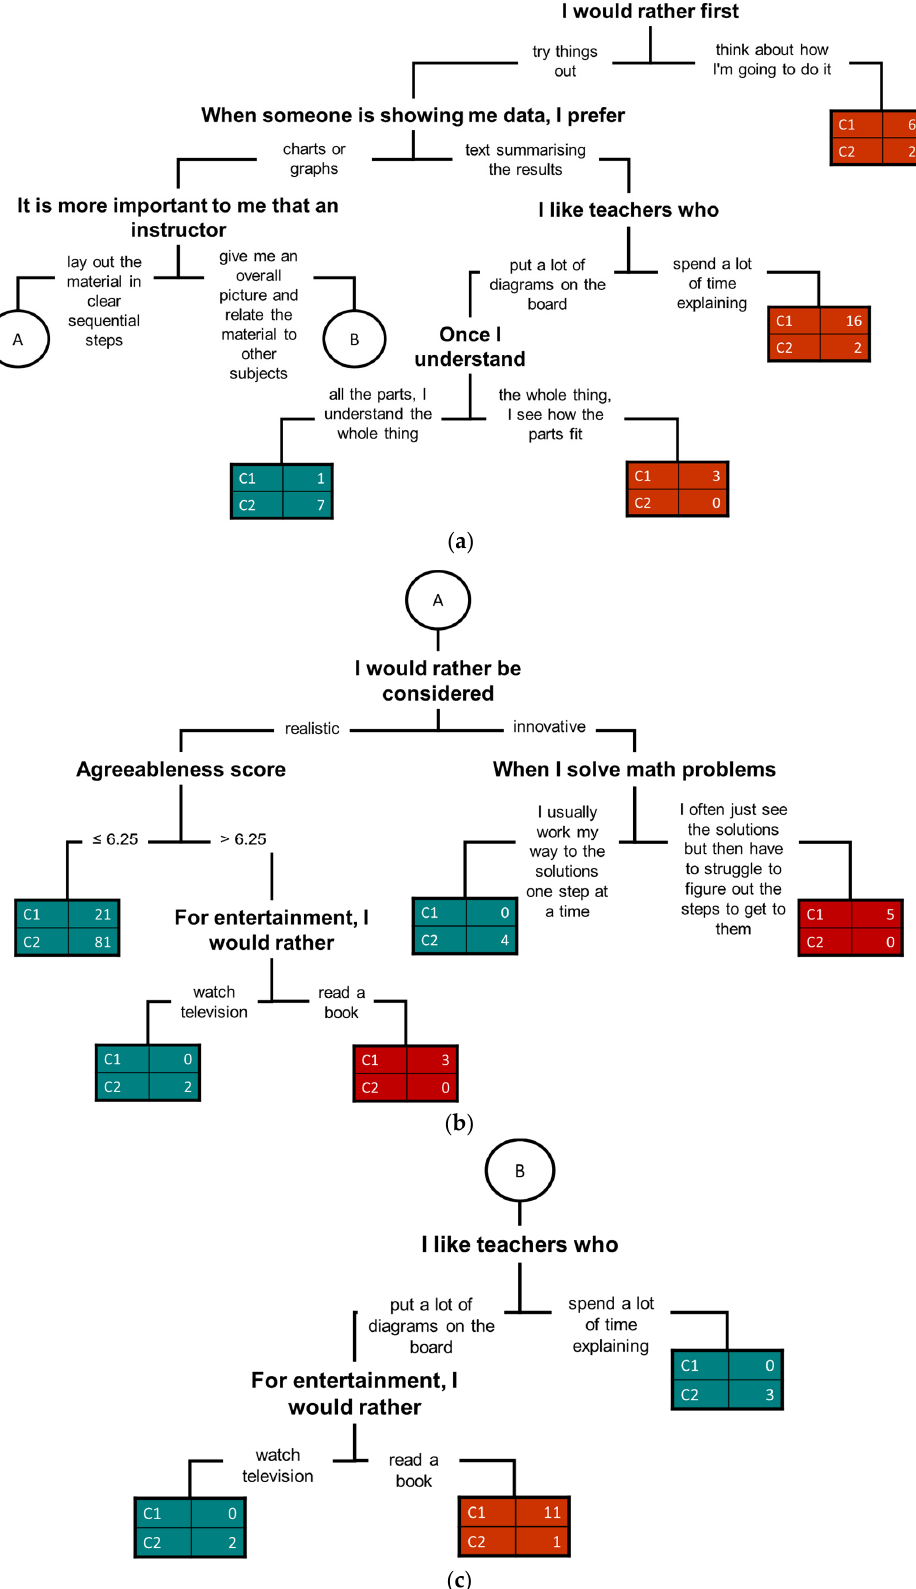
Figure 4. ( a ) Decision tree model; ( b ) decision tree model (part A); ( c ) decision tree model (part B).